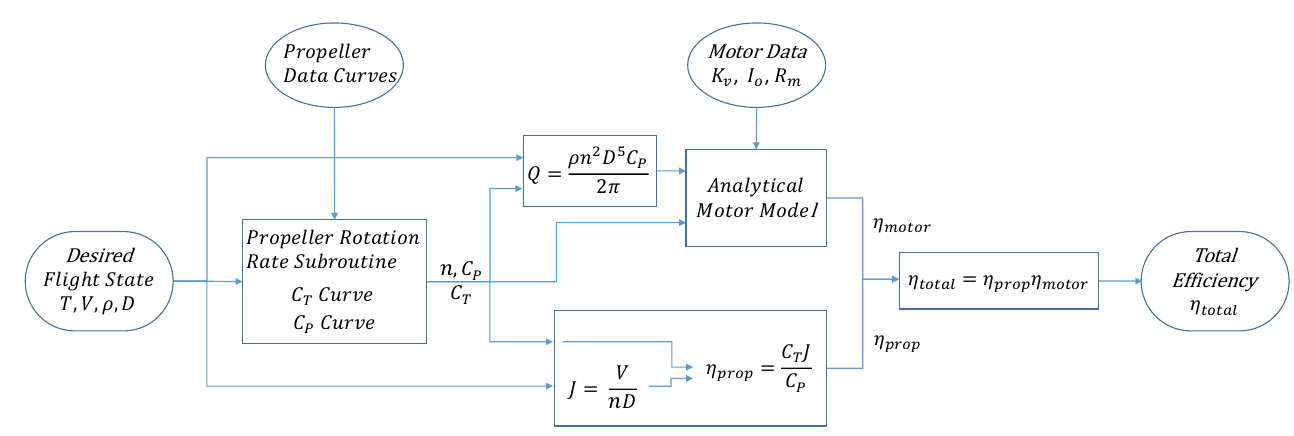
Figure 14. Process diagram for the Mission-Based Propulsion System Optimization .